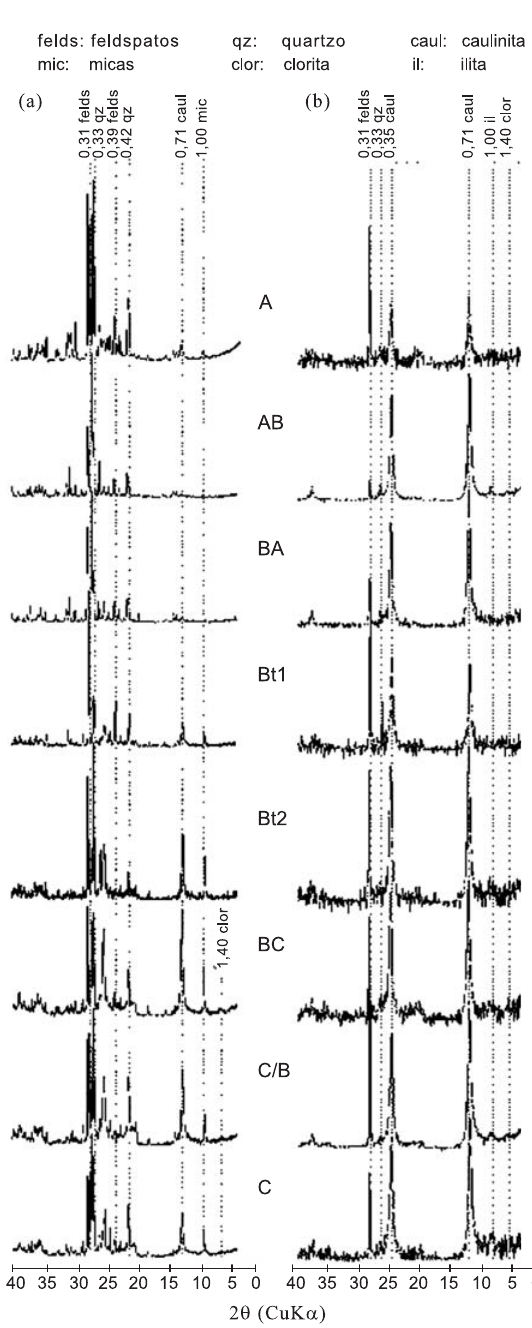
Figura 1. Difratogramas de raios X de K 25°C de todos os horizontes do Argissolo Vermelho-Amarelo: (a) fração silte e (b) fração